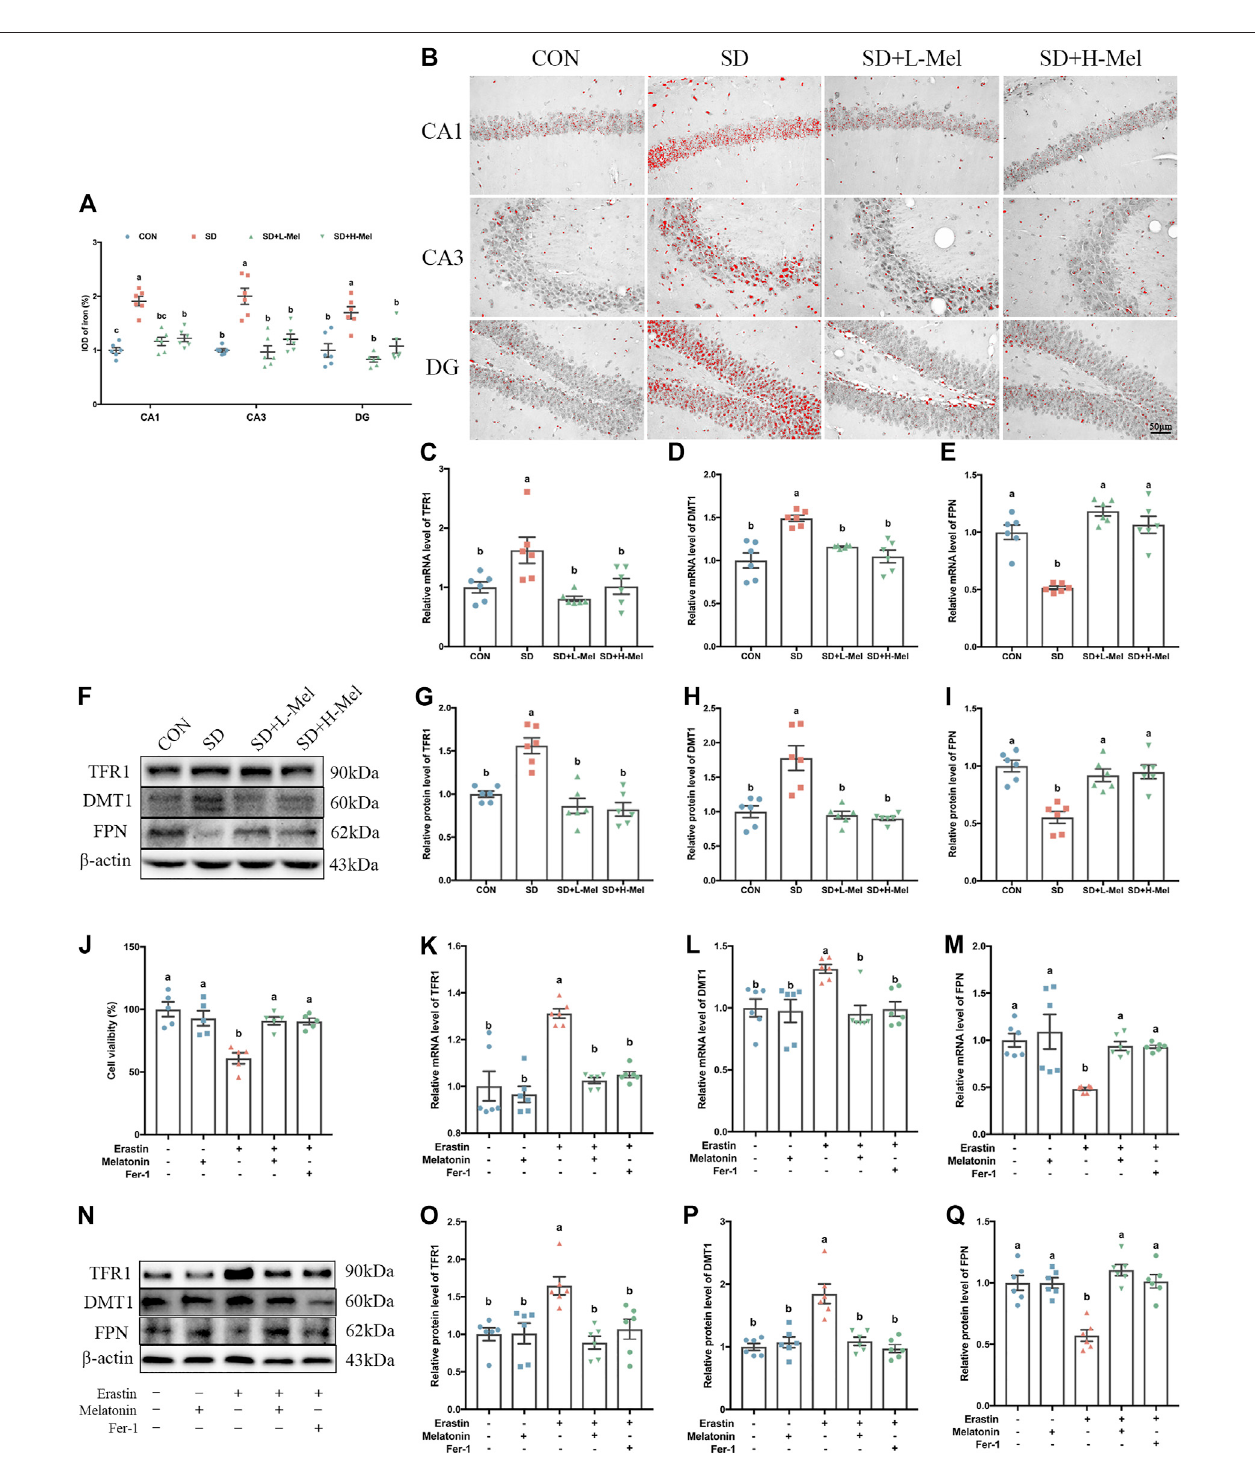
FIGURE 3 | Effect ofmelatonin onironaccumulation and irontransporter proteinsinthe hippocampus ofsleep-deprivedmice. (A) Relative IOD ofiron-positive cells in the hippocampal CA1, CA3, and DG areas ( n (cid:1) 6). (B) Micrographs depict iron labeling in mouse hippocampal sections. The iron-staining results were processed using ImageJ.Irondepositswereobservedasredgranules.Bar (cid:1) 50 μ m. (C – E) RelativemRNAlevelsofirontransporterproteinsTFR1,DMT1andFPNinthehippocampus( n (cid:1) 6). (F – I) RelativeproteinlevelsofirontransporterproteinsTFR1, DMT1and FPNinthehippocampus( n (cid:1) 6). (J) Relativecellviability ( n (cid:1) 5). (K – L) RelativemRNAlevelsof irontransporterproteinsTFR1,DMT1andFPNinHT-22cellsexposedtoErastinandmelatoninorFer-1( n (cid:1) 6). (N – Q) RelativeproteinlevelsofirontransporterproteinsTFR1, DMT1 and FPN in HT-22 cells exposed to Erastin and melatonin or Fer-1 ( n (cid:1) 6). Differences were assessed using one-way ANOVA. The result represents the mean ± standarderrorofthemean.Valuesnotsharingacommonsuperscriptletterdiffersigni fi cantlyat p < 0.05;thosewiththesameletterdonotdiffersigni fi cantly( p ≥ 0.05).CON: controlgroup,SD:sleepdeprivationgroup,SD+L-Mel:SD+lowmelatonin(20 mg/kg)supplementgroup,SD+H-Mel:SD+highmelatonin(40 mg/kg)supplementgroup.